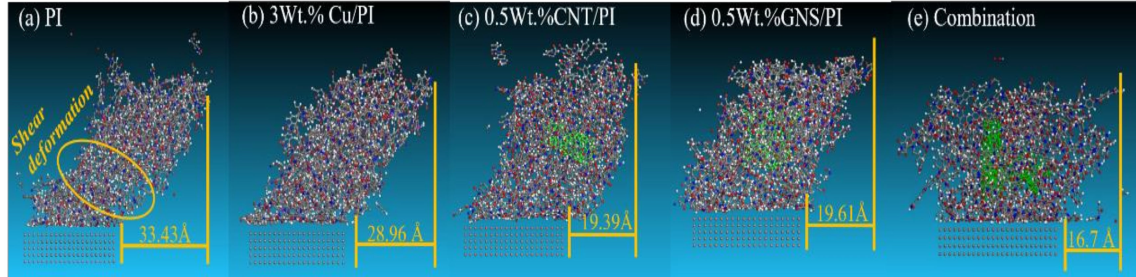
Figure 10. Model of the shear deformations of ( a ) PI, ( b ) 3 wt.% Cu/PI, ( c ) 0.5 wt.% GNS/PI, ( d ) 0.5 wt.% CNT/PI, and ( e ) Combination.